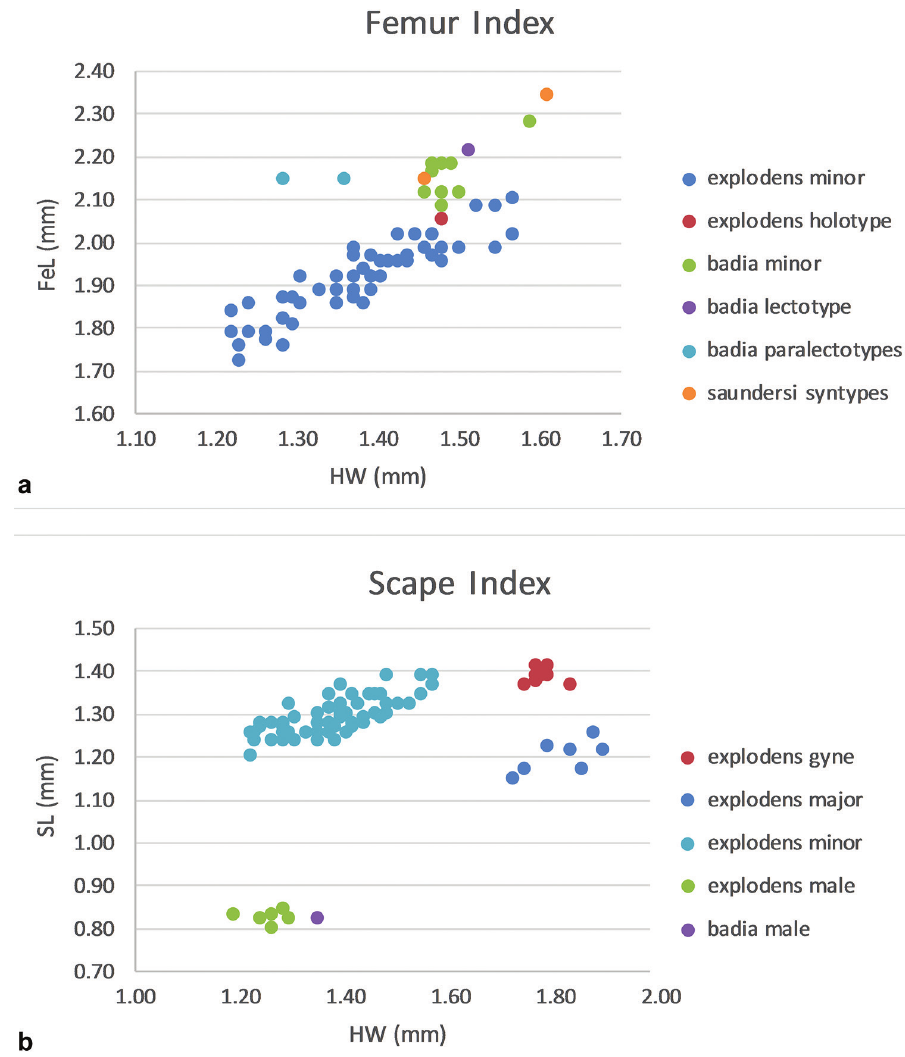
Figure 8. Variation of relevant morphometric measurements for the distinction of castes and species; a Metafemur length (FeL) in relation to head width (HW) for minor workers of C. explodens sp. n., as well as minor workers of C. badia and C. saundersi (type specimens plotted separately) b Scape length (SL) in relation to head width (HW) for minor workers, major workers, gynes and males of C. explodens sp. n., as well as male of C.